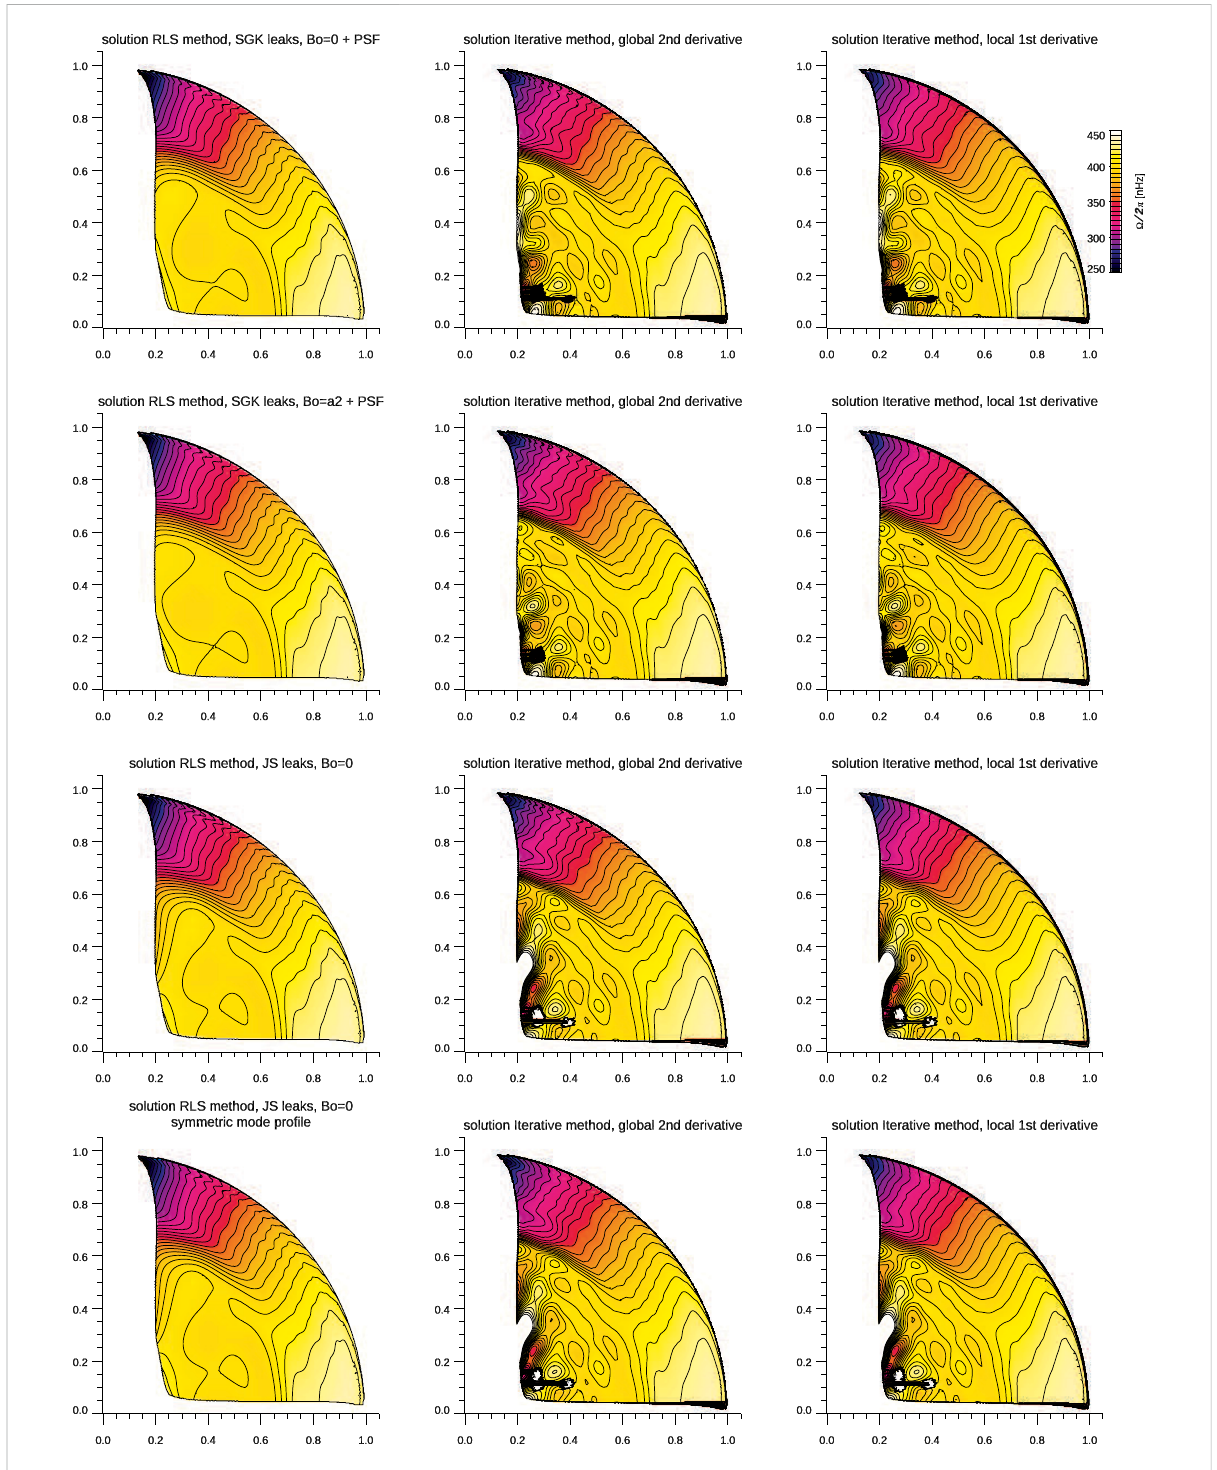
FIGURE 14 Rotation inversion solutionscomputedforthreeinversionmethodologies(columns) andfoursetsofsplittings(rows).Fromlefttoright:theRLS method, the iterative global second-derivative method, and the iterative local fi rst-derivative inversion method. From top to bottom: SGK leaks, B o (cid:3) 0; and JS leaks and B o (cid:3) 0, using a symmetric mode pro fi B o (cid:3) 0, and PSF; SGK leaks, B o (cid:3) a 2 , and PSF; JS leaks and